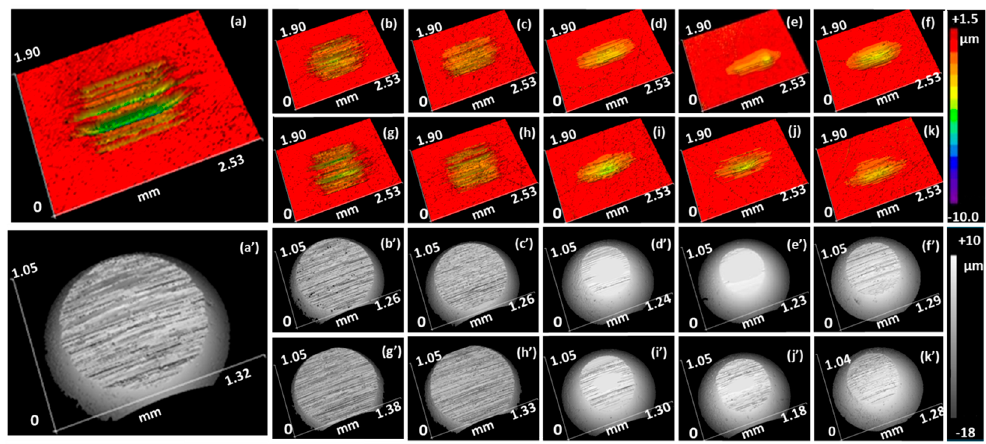
Figure 6. Three-dimensional (3D) disc and ball wear pictures while lubricating by lignin/EG lubricants. Load: 2.5 GPa, testing duration: 1 h, temperature: 25 °C. Disc wear images: ( a ): EG; ( b ): Load: 2.5 GPa, testing duration: 1 h, temperature: 25 ◦ C. Disc wear images: ( a ): EG; ( b ):